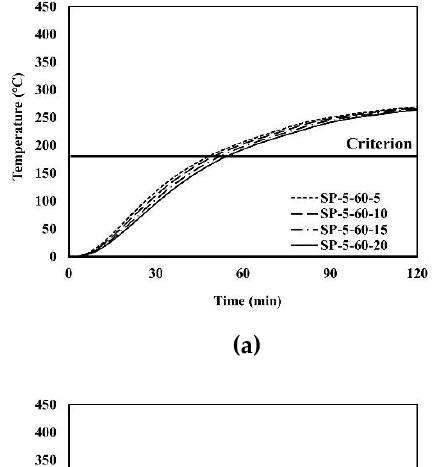
Figure 18. Time history of average temperatures with dp = 60 mm: ( a ) SP-5-60- x; ( b ) SP-10-60-x; ( c ) SP-15-60-x; ( d ) SP-20- 60-x.